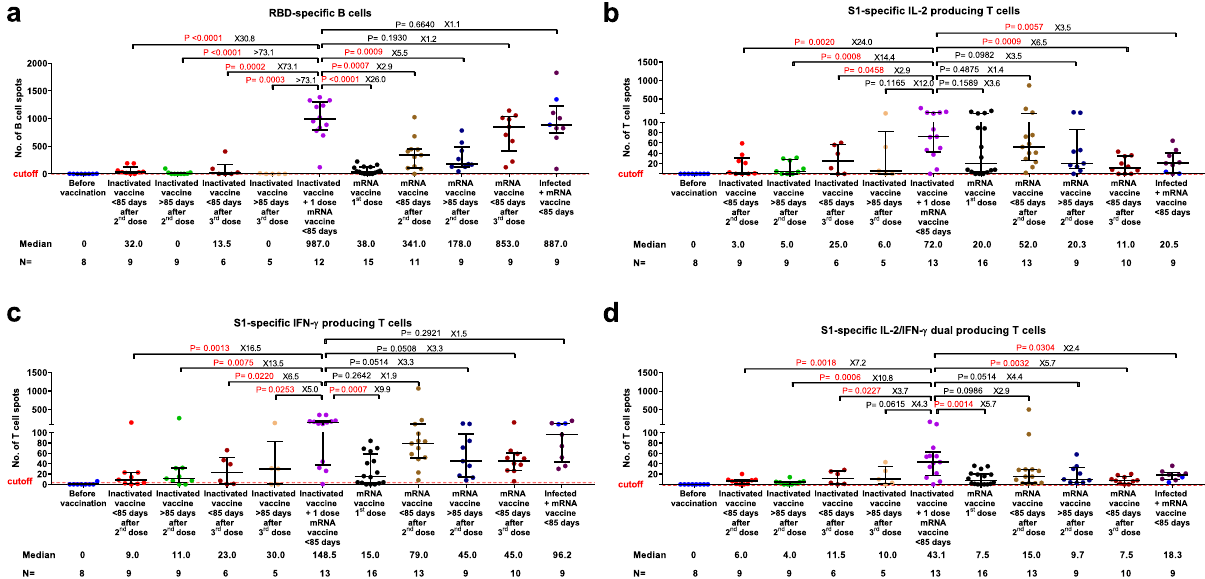
Fig. 3 Speci fi c memory B and T cell responses in different vaccination groups. Receptor-binding domain (RBD)-speci fi c, IgG producing memory B cell ( a ) and spike ectodomain 1 (S1)-speci fi c T cell ( b – d ) responses in different groups of vaccinated individuals. Symbols represent individual subjects and horizontal black lines indicate the median. The cutoff-value (dashed red line) and number of fold differences of median between groups are indicated. As the median number of RBD-speci fi c cells was 0 for two groups, the number of fold change differences compared to inactivated vaccine + one dose mRNA vaccine was estimated to be more than the highest calculated value (>73.1-fold). For each group, the number of samples ( N = ) and median number of speci fi c B cells or T cells are shown below the X -axis. In the last group, convalescent donors were color-coded based on receiving one (purple) or two doses (cyan) of mRNA vaccines. Whiskers indicate the interquartile range. Two-sided Mann – Whitney U test was used and P < 0.05 was considered statistically signi fi cant and marked with red color. IL-2: interleukin 2, IFN- γ : Interferon